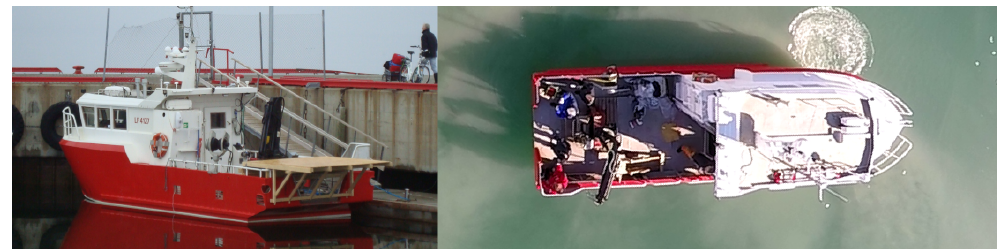
Figure 5. MS Teisten in the Ny-Ålesund harbour and in view from an aerostat.